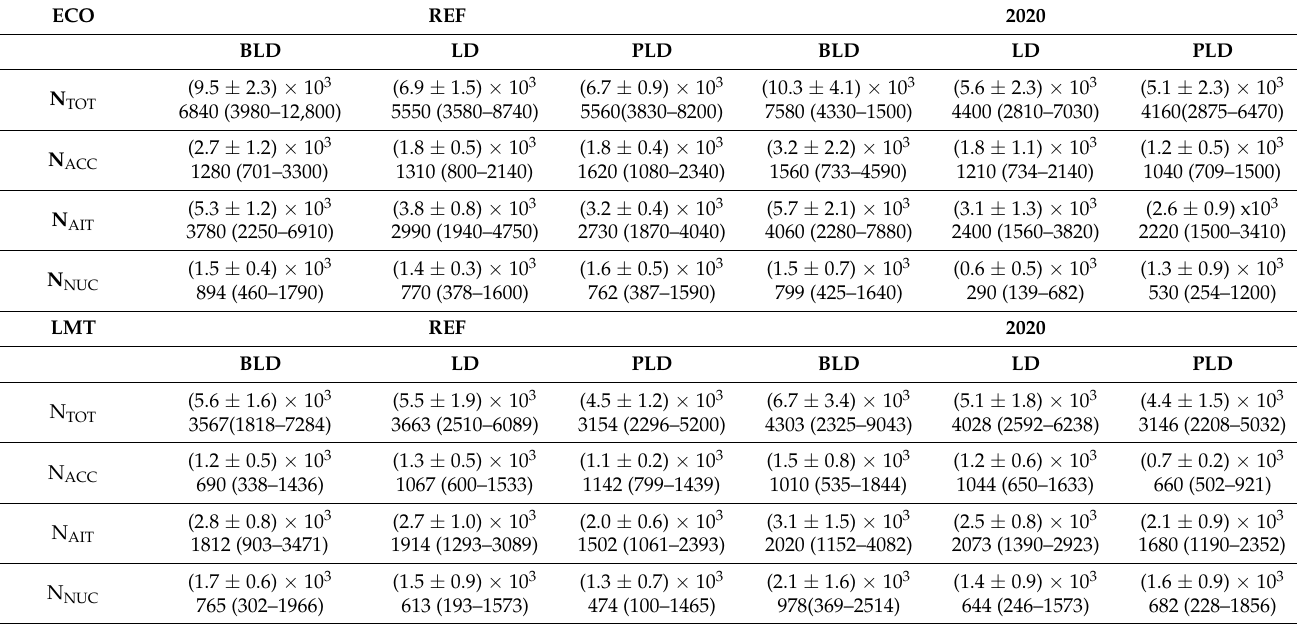
Table 1. Arithmetic means ± 1 standard deviation and medians (25–75th) percentiles of the total (10 nm < Dp < 800